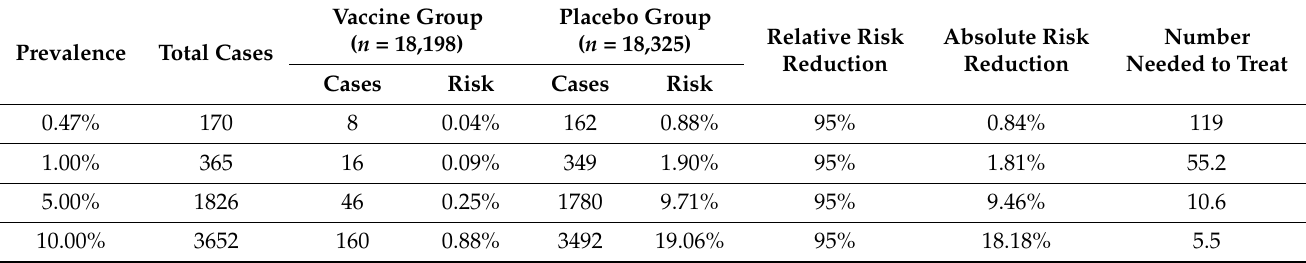
Table 1. Effects of increasing prevalence of disease affecting ARR with a constant RRR in the BNT162b2 study (total population: 36,523) [33].